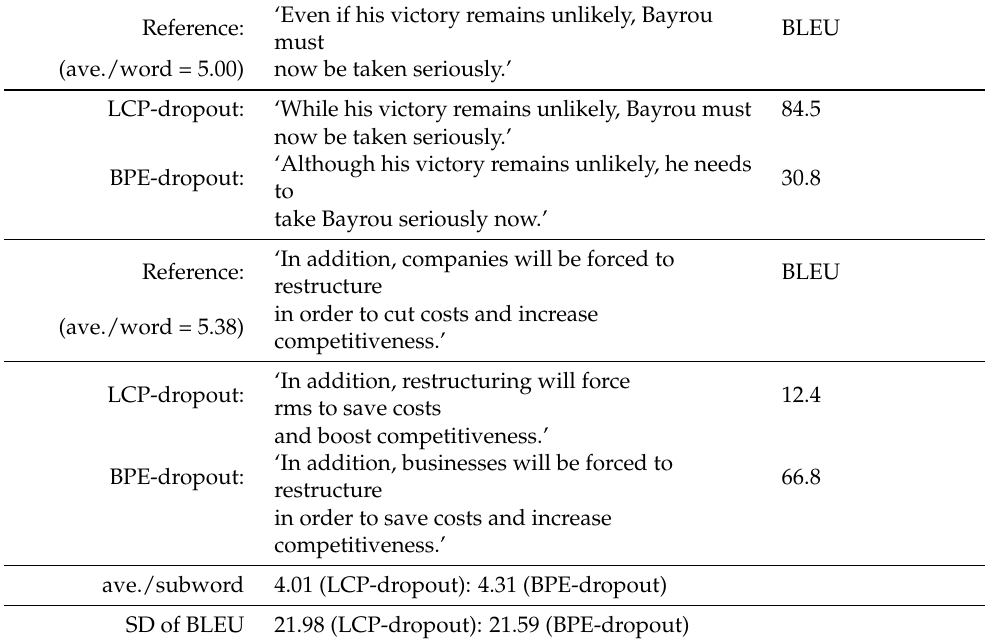
Table 7. Examples of translated sentences by LCP-dropout ( k = 0.01 ) and BPE-dropout ( p = 0.1 ) with the reference translation for News Commentary v16. We show the average word length (ave./word) for each reference sentence as well as the average subword length (ave./subword) generated by the respective algorithms for the entire corpus. We also show the BLEU scores between the references and translated sentences as well as their standard deviations